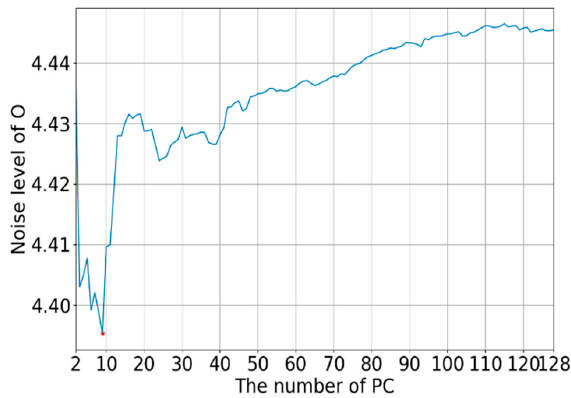
Figure 4. Relationship between the noise level and optimum number of PCs of the observed BT; the location of the minimum noise level is marked by a red